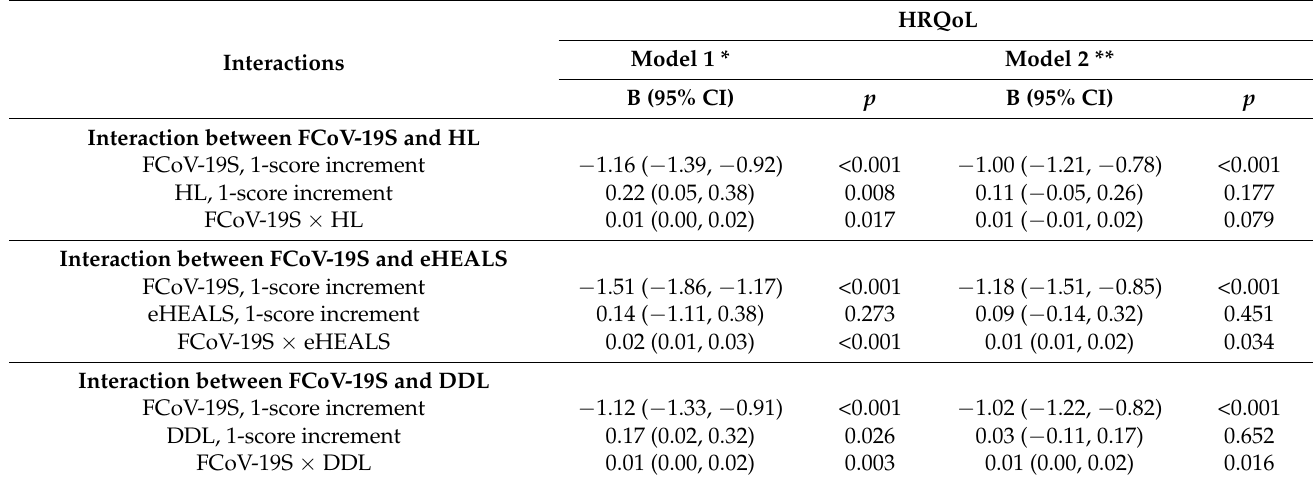
Table 4. Interactions of the fear of COVID-19 with health literacy, eHealth literacy, and digital healthy diet literacy on health-related quality of life ( n = 4348).